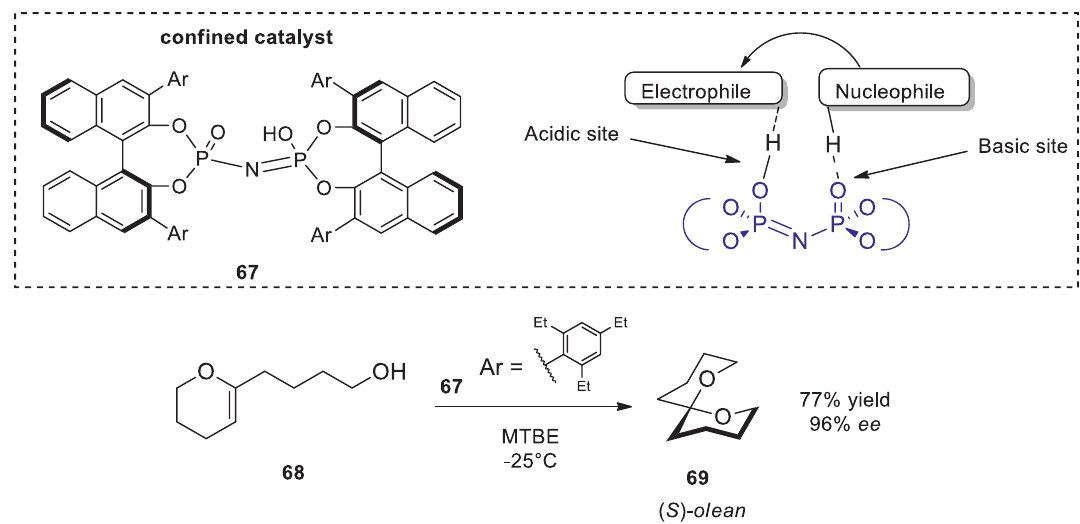
Figure 17 . The asymmetric spiroacetalisation reaction catalysed by con fi ned BA; bifunctional con fi ned catalysts ’ s pocket, from Ref. [85].